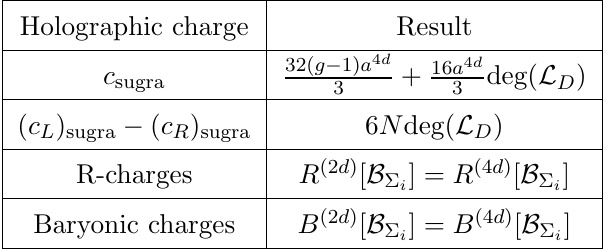
Table 2 . Holographic charges for the universal twist solution with elliptic surface S (cid:28) . Here, a 4 d is the 4d central charge (5.18) associated to the dual of the AdS 5 (cid:2) SE 5